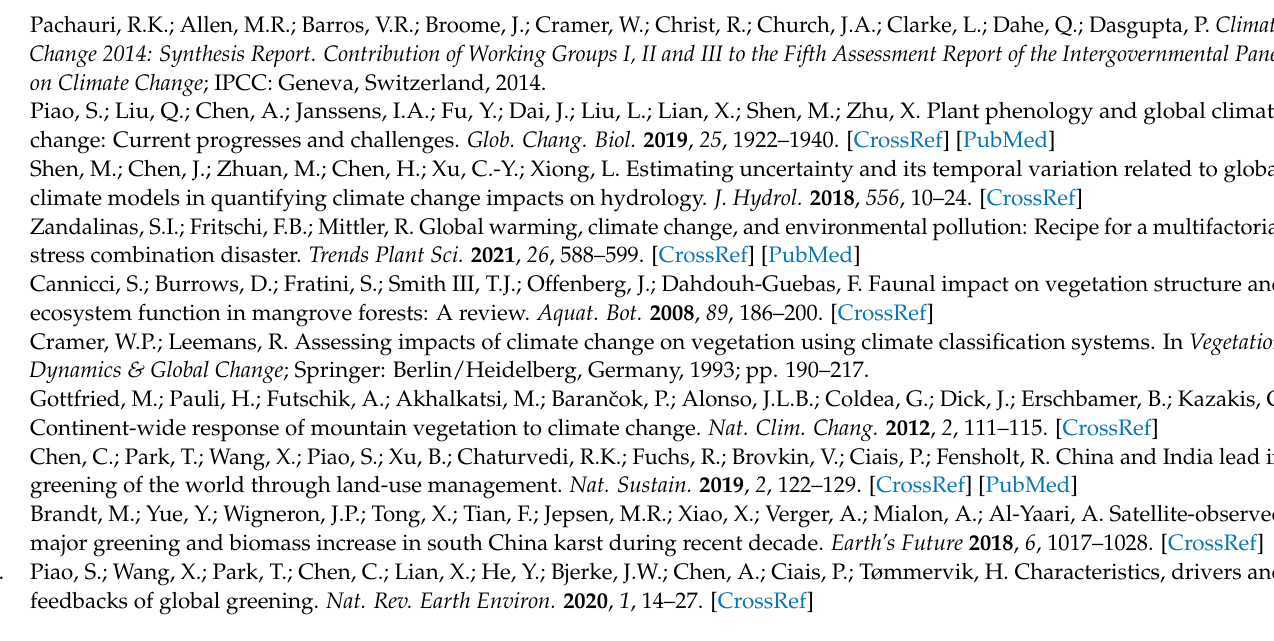
from 1982 to 2017; Figure S2. Validation of rainfall erosivity factor. (a) Our simulated rainfall erosivity factor. (b) Rainfall erosivity factor based on global site data released by Climate Prediction Center (CPC), (c) Fitted scatter plot of two rainfall erosivity factors (a and b). (d) The point used to extract validation data. Figure S3. Validation of soil erodibility factor. (a) Our simulated soil erodibility factor. (b) Soil erodibility factor based on International Soil Reference and Information Centre (ISRIC). (c) Fitted scatter plot of two soil erodibility factors (a and b). (d) The point used to extract validation